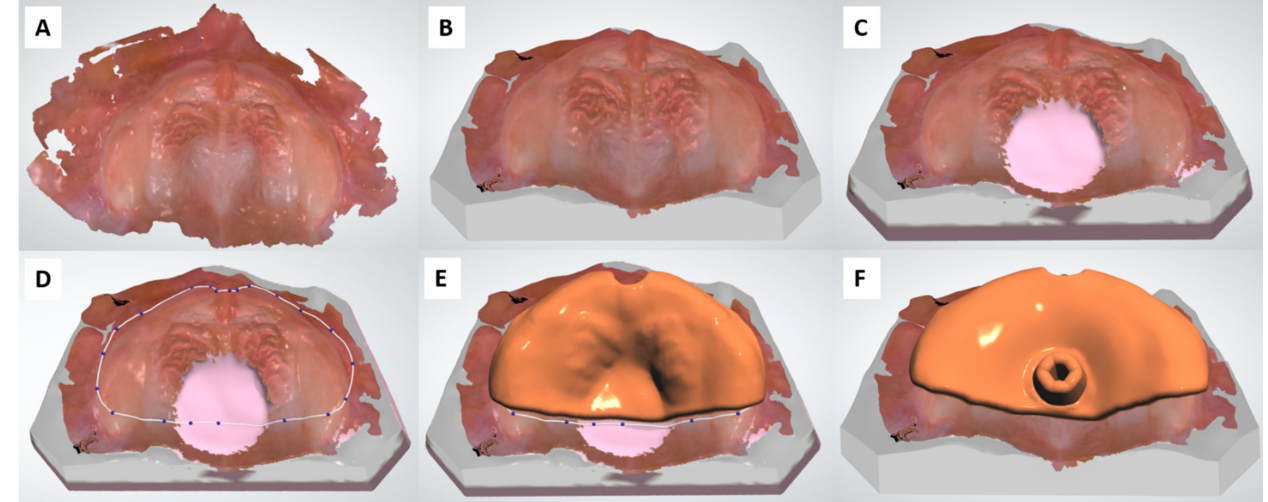
Figure 2. Plate design process in 3 Shape Appliance Designer and Dental Designer [7]. ( A ) Scan of the patient, ( B ) Model creation based on an intraoral scan, ( C ) Wax addition in regions of conflict in the model, ( D ) Definition of the plate area, ( E ) Construction of the plate, ( F ) Placement of the stimulation plate and smoothening of the plate.